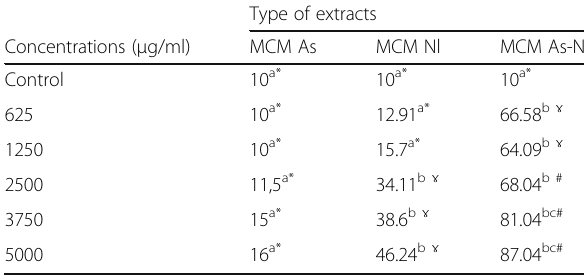
Table 2 Effect of Methylene Chloride-Methanol of Annona senegalensis , Nauclea latifolia and their mixture on embryonated egg (%) according to concentrations after 10 h of exposure